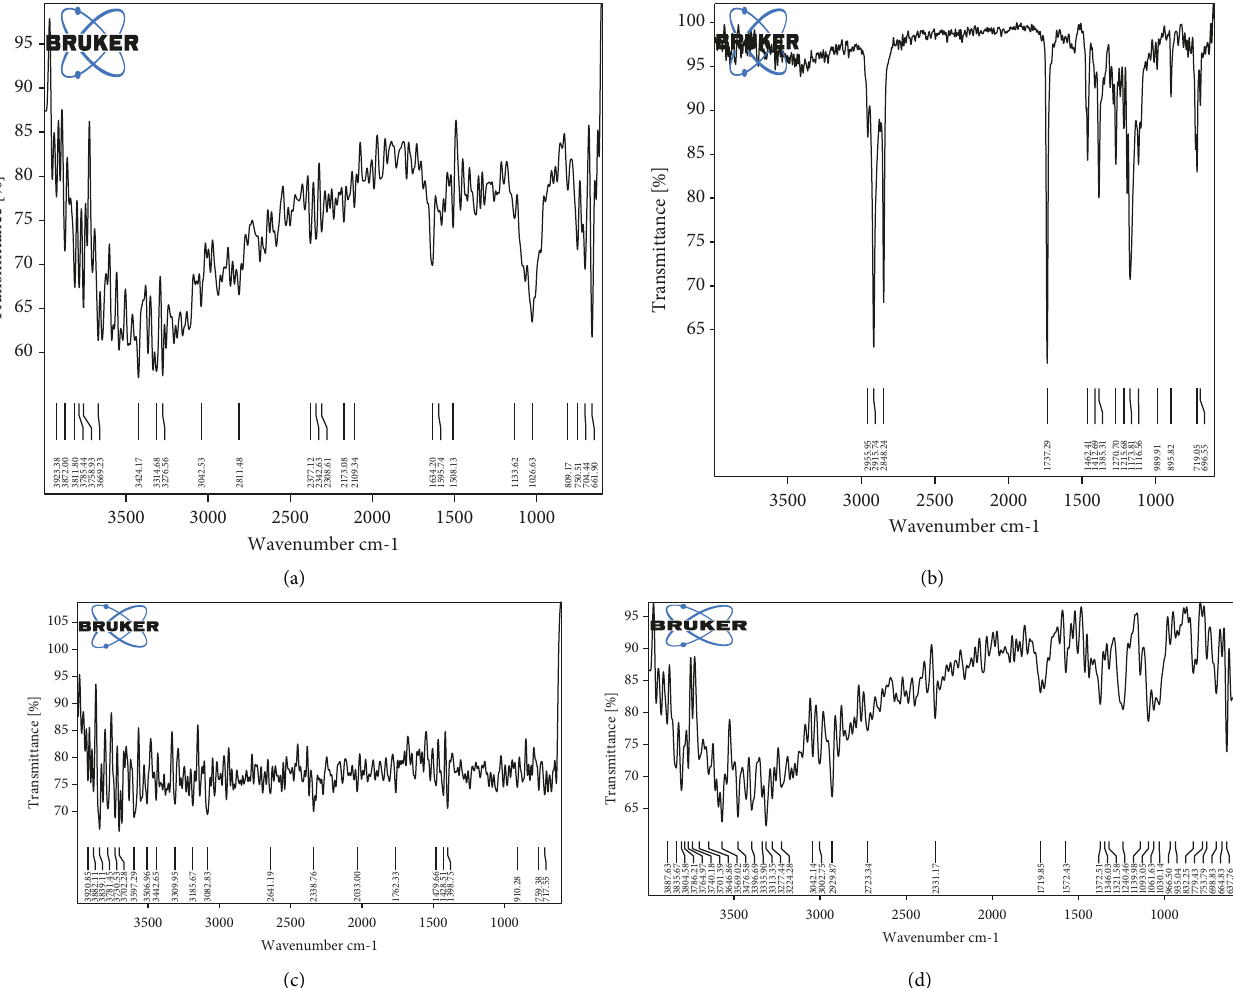
Figure 6: (a) FTIR spectra of Bacopa monnieri , (b) FTIR spectra of GMS, (c) FTIR spectra of Polyvinyl alcohol (PVA), and (d) FTIR spectra of microneedle patch.